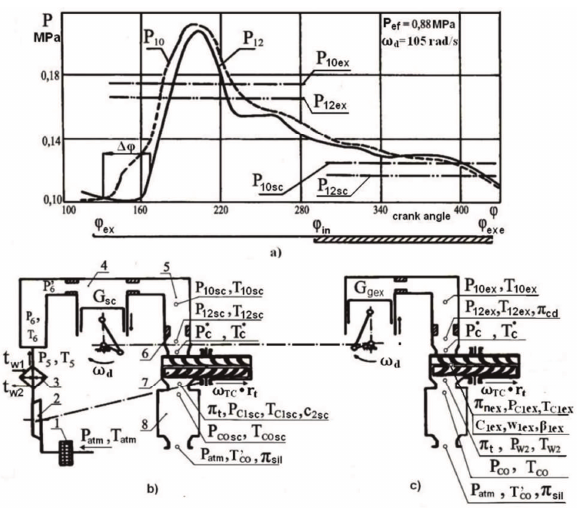
Fig. 1. Change in pressure in exhaust manifold ( а ) calculation model of а 8 С 22 diesels with pulse supercharging at scavenging (b) and at free exhaust